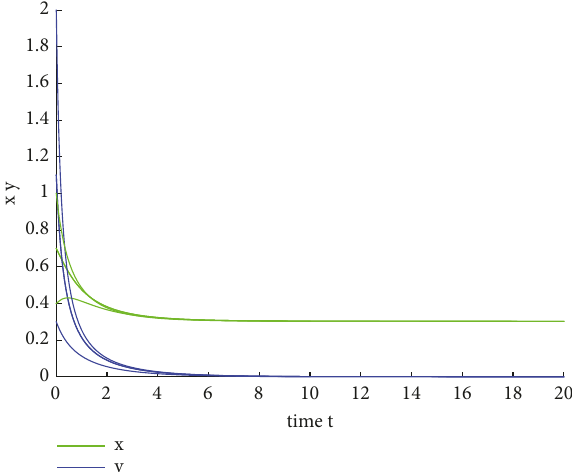
Figure 3: Solutions (𝑥(𝑡),𝑦(𝑡)) of system (23) with the initial conditions (𝑥(0),𝑦(0)) = (1,0.3) , (0.4, 2) , and (0.7, 1.1)